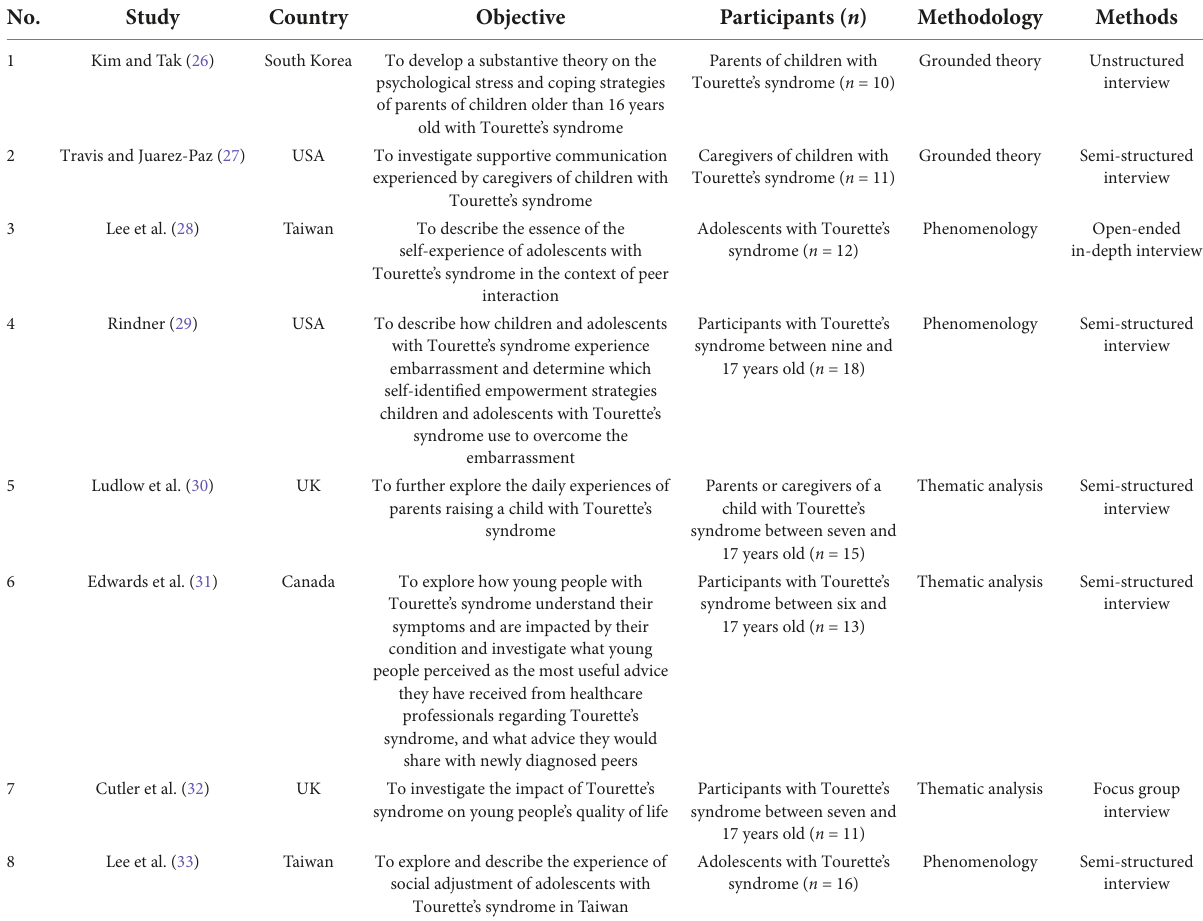
TABLE 1 Characteristics of the included